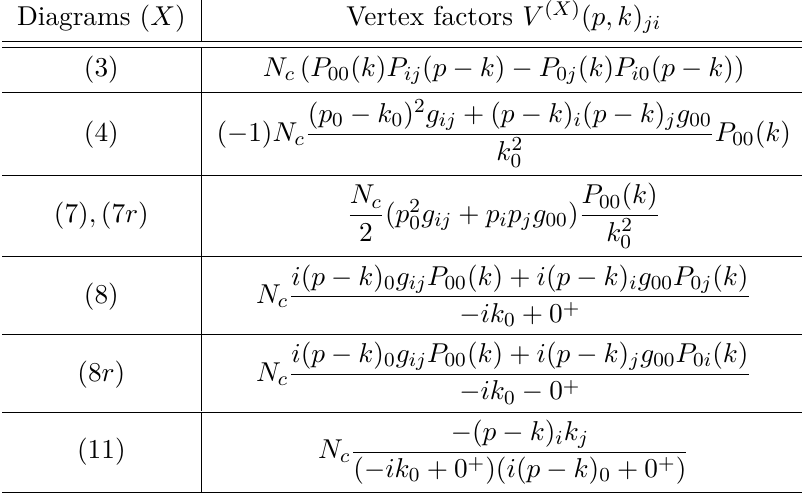
Table 6. Summary of vertex factors of diagrams with 2 propagators contributing to